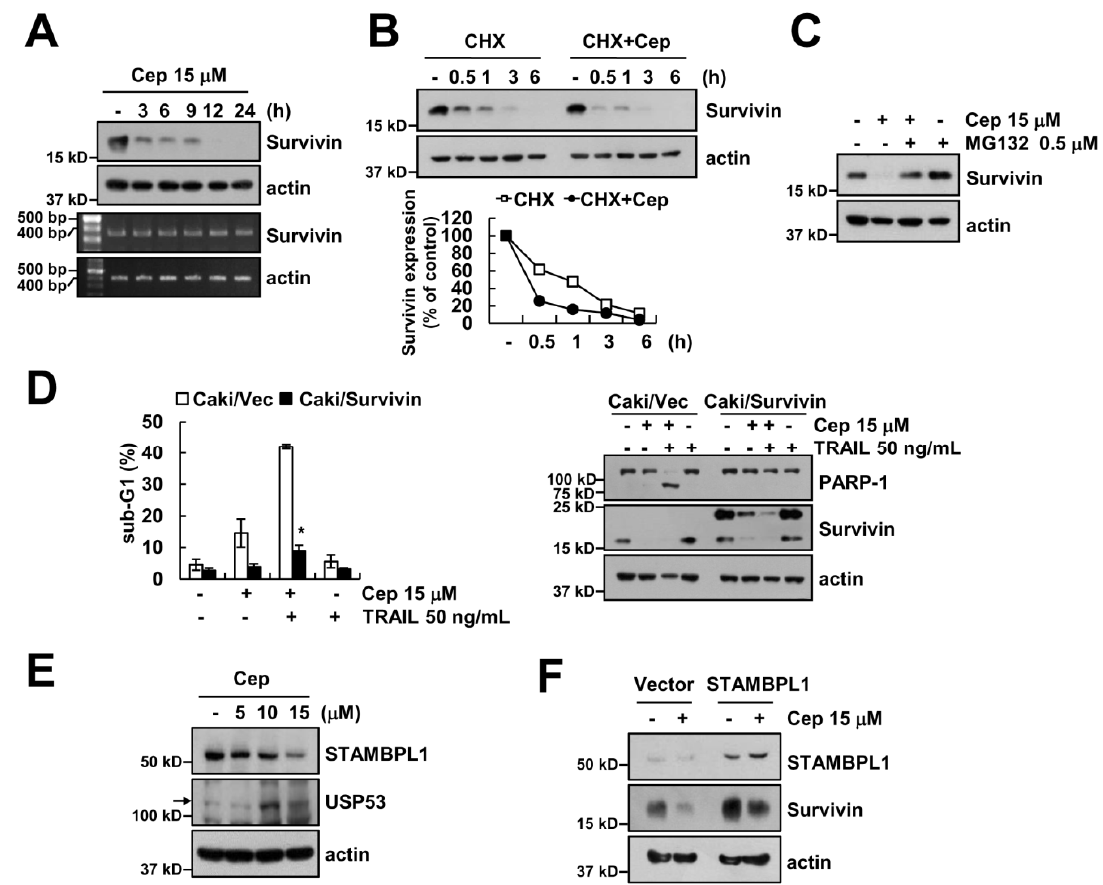
Figure 4. Downregulation of survivin is involved in CEP plus TRAIL-induced apoptosis. ( A ) Caki cells were treated with 15 μM CEP for 3–24 h. The survivin expression levels were determined by Western blotting and RT-PCR; ( B ) Caki cells were treated with 20 ng/mL CHX alone, or CHX plus CEP for 0.5–6 h. The survivin protein band intensity was quantified using ImageJ (public domain JAVA image processing program); ( C ) after pretreatment with 0.5 μM MG132 for 30 min, Caki cells were treated with 15 μM CEP for 18 h; ( D ) vector-transfected cells (Caki/Vec) and survivin-overexpressing cells (Caki/Survivin) were treated with 15 μM CEP and/or 50 ng/ml TRAIL for 18 h. ( E ) Caki cells were treated with CEP (5–15 μM) for 18 h; ( F ) Caki cells were transfected with control or STAMBPL1 expression vector, and then cells were treated with 15 μM CEP for 18 h. The sub-G1 population and protein levels were detected by flow cytometry and Western blotting, respectively. Data represent the mean ± SD of at least three independent experiments. * p < 0.05 compared with the CEP plus TRAIL-treated Caki/Vec.